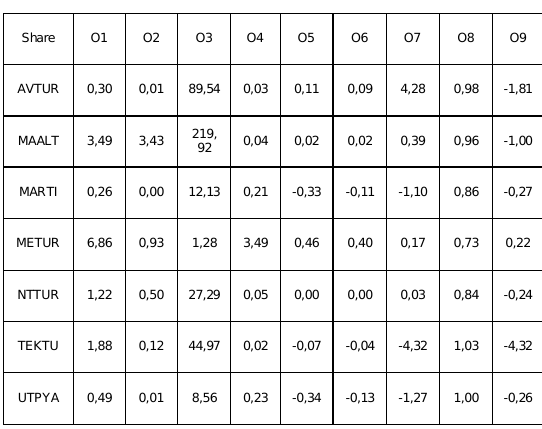
Table 8: Annual Standard Decision Matrix for the 2013- 2016 Period